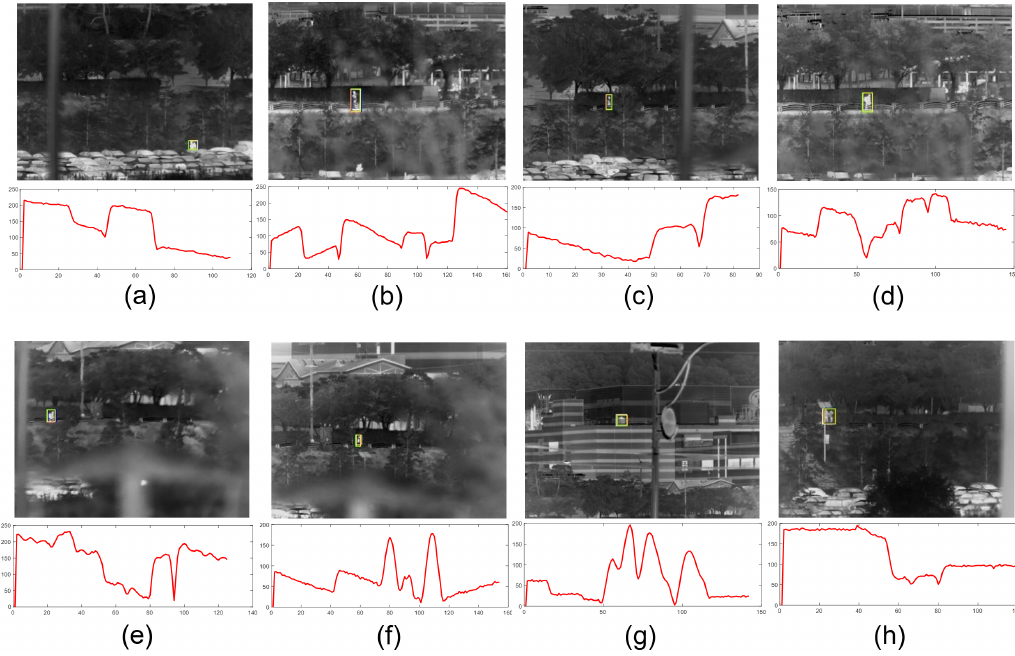
Figure 13. Videos and fast camera motion profiles of a real EOTS application. The solid red lines represent x-axis motion profiles. ( a – d ) have fast camera motion caused by the internal camera motor driver; ( e – h ) have fast camera motion caused by the external 6-DOF motion generator. The names of the sequences are ( a ) EOTS_parking, ( b )